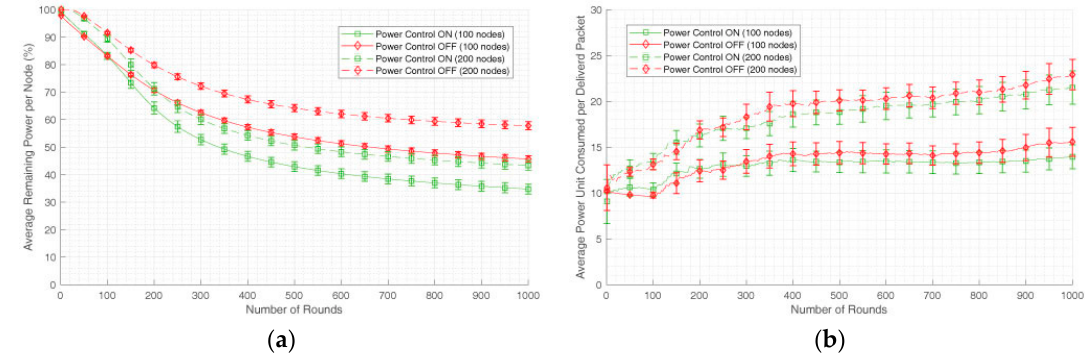
Figure 8. Network performance in a clustered network in terms of ( a ) average remaining power per node and ( b ) average power consumed per delivered packet.